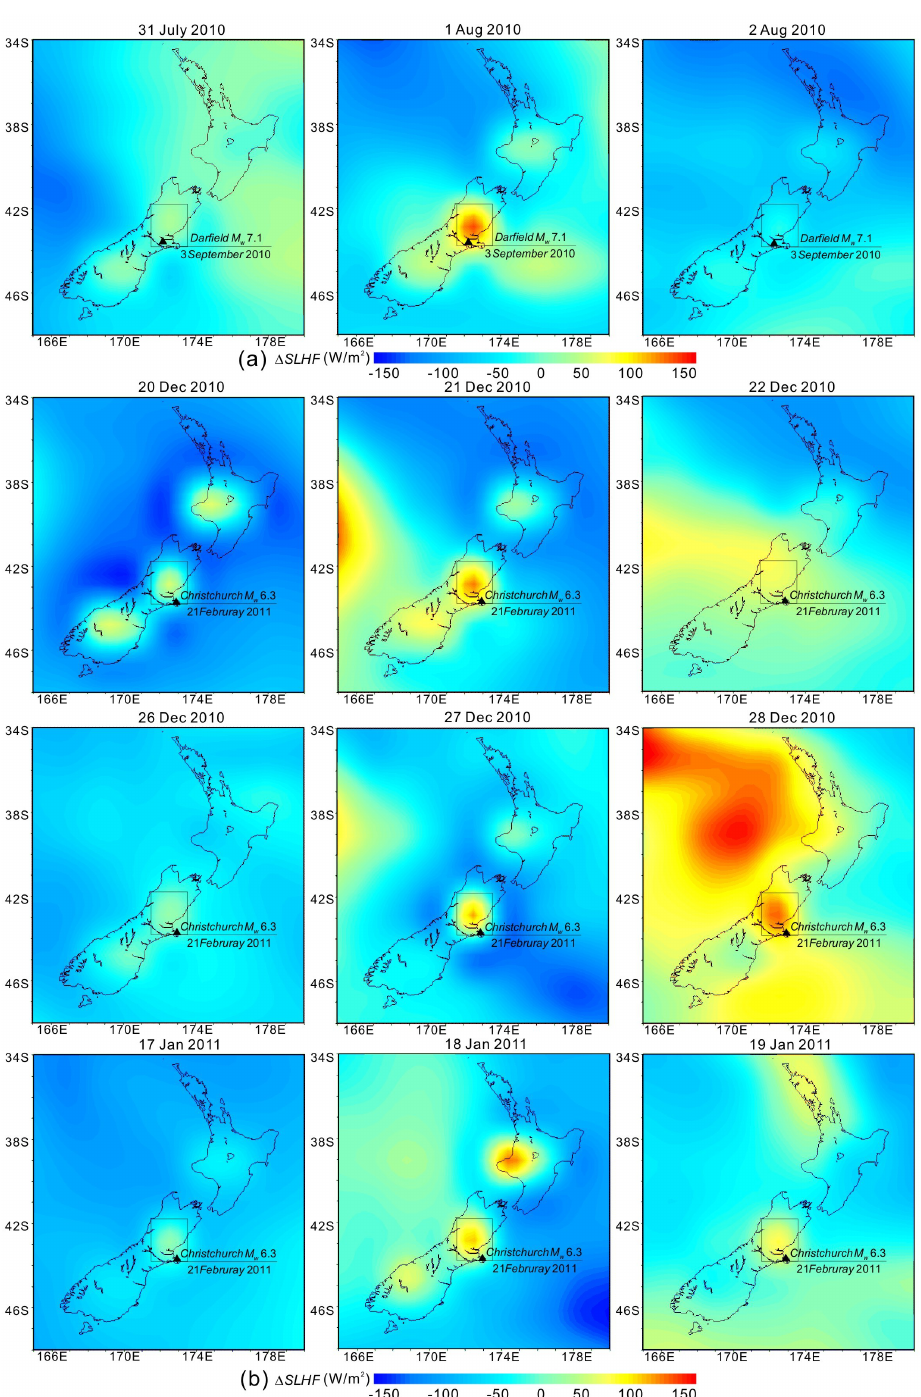
Fig. 5. (a) Spatial distribution of SLHF increment ( 1 SLHF ) from 31 July to 2 August 2010, obtained by subtracting the mean value of years without large ( M > 5 . 5) earthquakes (1980-2009), representing a background, from the data of 2010; (b) Spatial distribution of SLHF increment ( 1 SLHF ) on 20–22 December 2010, 26–28 December 2010 and 17–19 January 2011, obtained by subtracting the mean value of years without large ( M > 5 . 5) earthquakes (1980–2009 or 1981–2010), representing a background, from the data of 2010 and 2011. The black triangles in (a) and (b) indicate the epicenter of the mainshock and the 21 February 2011 aftershock, respectively. The black rectangular boxes indicate the epicenter pixel (42.86 ◦ S 172.5 ◦